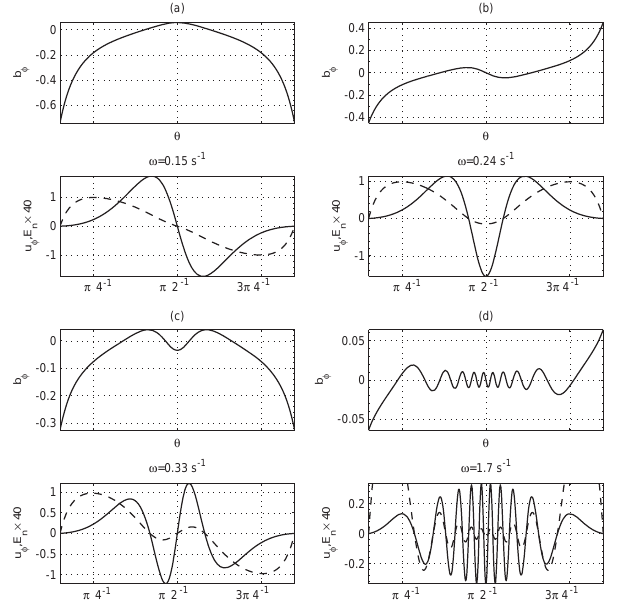
Figure 6. Harmonic wave forms on the midnight meridional plane ( φ = π ) of the compressed-dipole field. Format is the same as Fig.